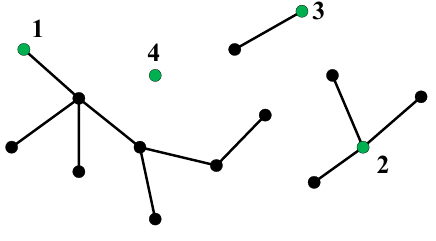
Figure 7. Four subtrees in the